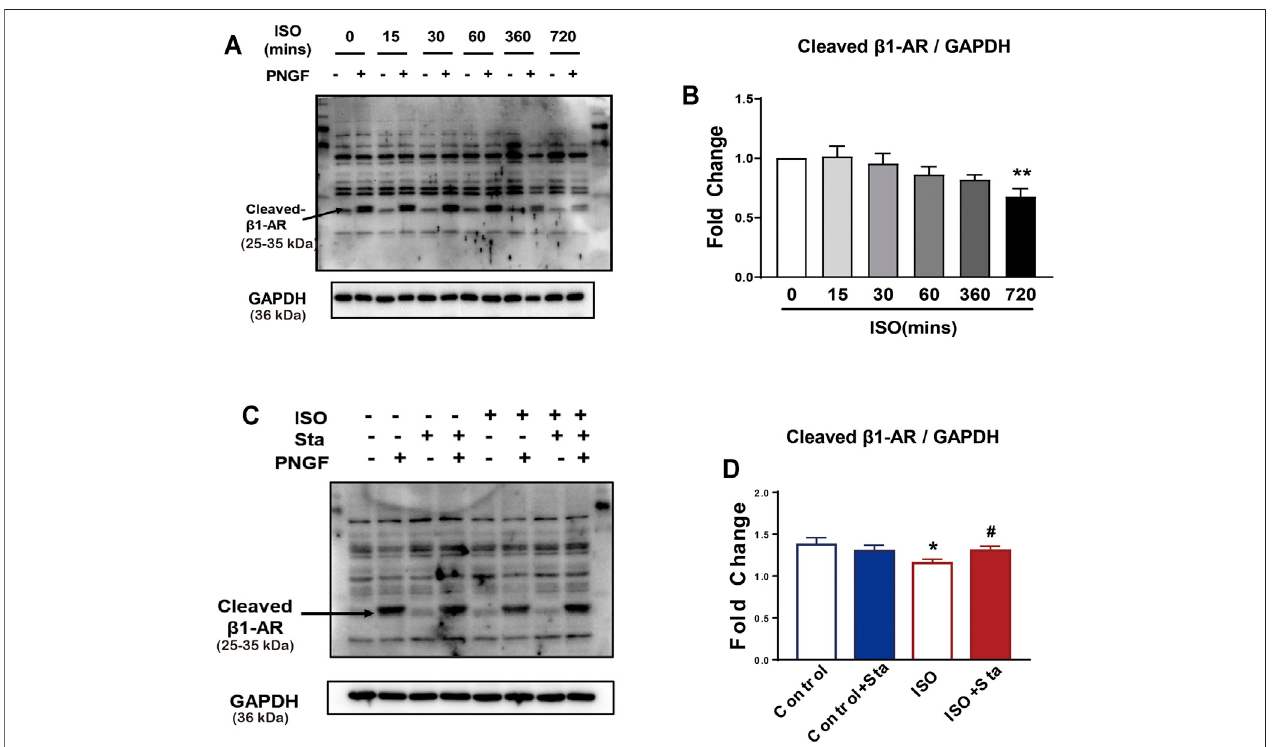
FIGURE 5 | The N-glycosylation of β 1AR decreased after continuous ISO stimulation, while stachydrine hydrochloride can increase its expression in vitro . (A) Representative Western blot of N-glycosylation of β 1AR after PNGase F digestion exposed to ISO at different time points in NRVMs (from three independent experiments). (B) Quanti fi cation ofcardiac N-glycosylation of β 1AR. (C) RepresentativeWesternblotofStaonN-glycosylationof β 1ARexposedtoISOat 720 min(from threeindependentexperiments). (D) Quanti fi cationofcardiacN-glycosylationof β 1AR.Thedataareexpressedasmean±standarderrorofmean,* p < 0.05versus control; # p < 0.05 versus ISO. β 1AR, β 1 adrenergic receptors; ISO, isoproterenol; Sta, stachydrine hydrochloride; NRVMs, neonatal rat ventricular